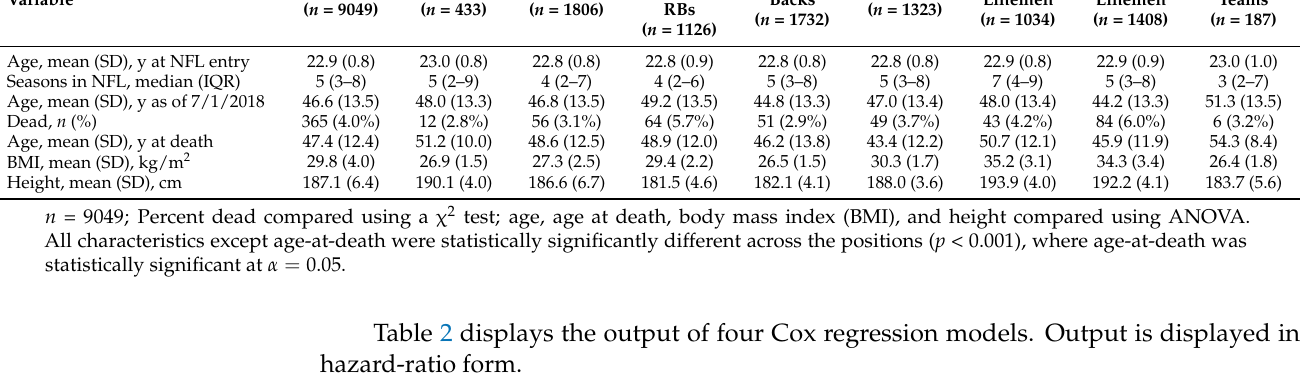
Table 1. National Football League Player Demographics (Players Entering 1970–2017; n = 9049).